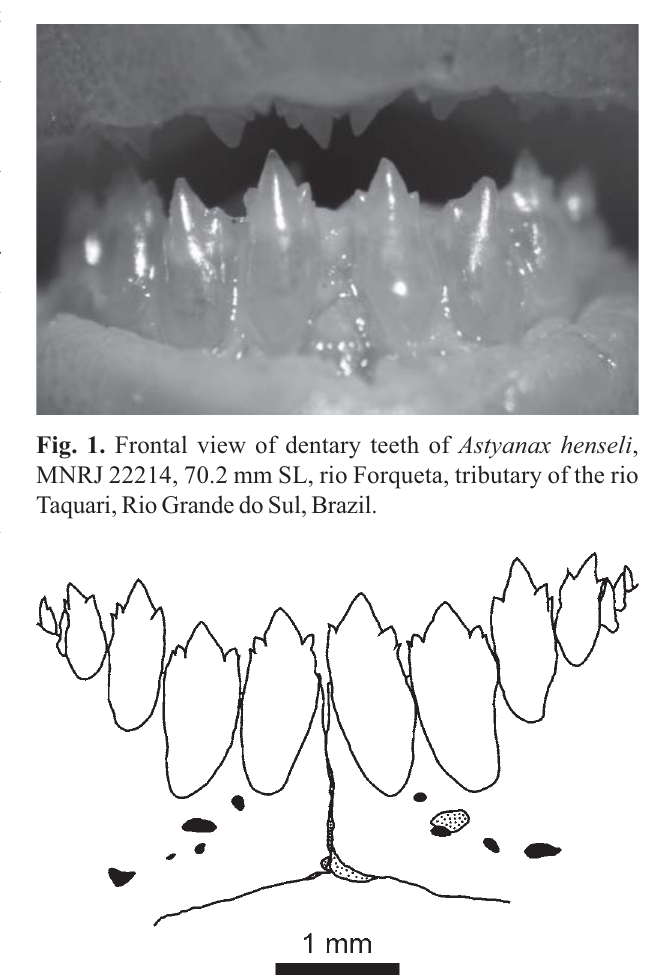
Fig. 2. Frontal view of dentary teeth of Astyanax hensel i, MNRJ 14186, arroio do Carvalho, Vila do Carvalho, on road Santo Antônio da Patrulha - Vila Caraá, rio dos Sinos drain- age, Rio Grande do Sul, Brazil.